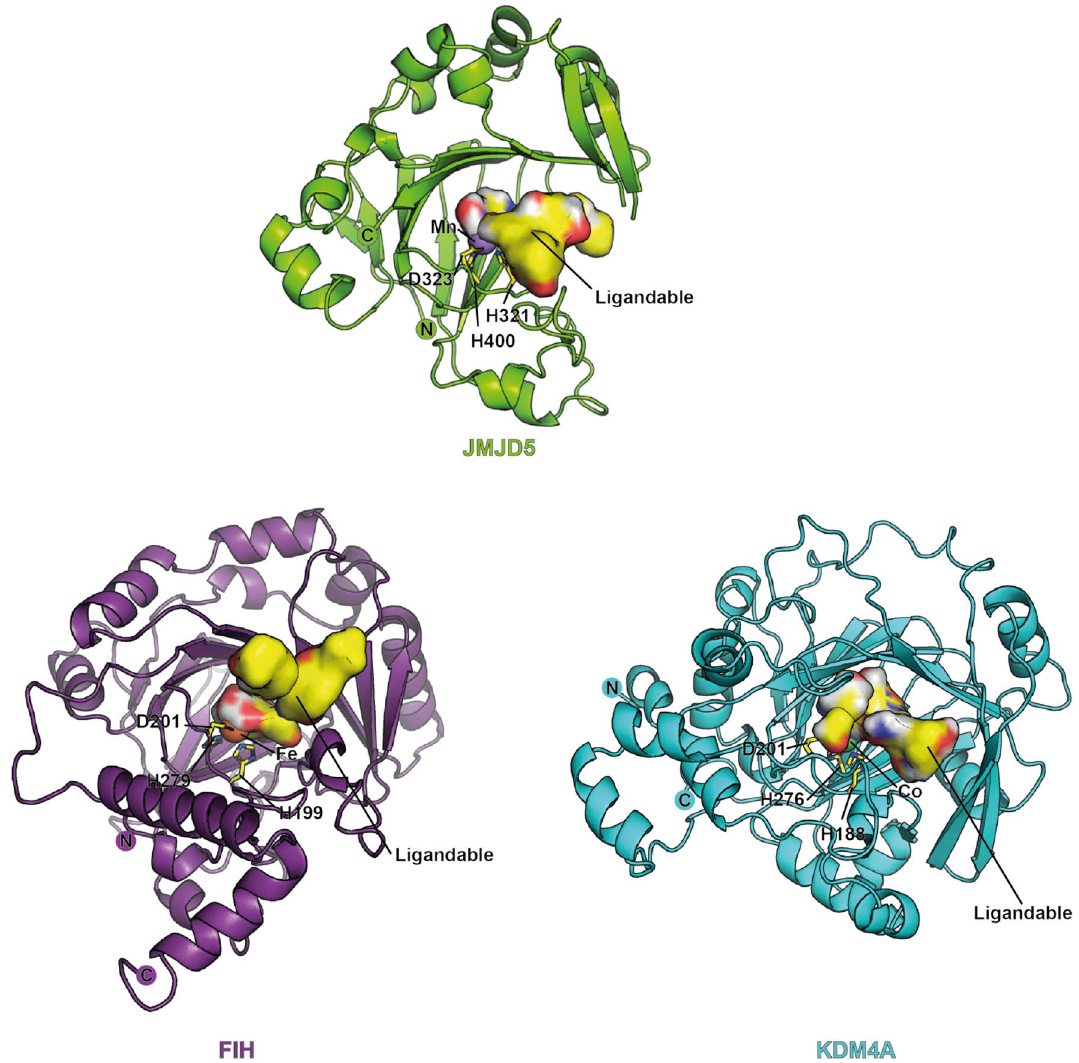
Figure 4. Comparisons of the 2-oxoglutarate binding pocket of JMJD5 with those of FIH and